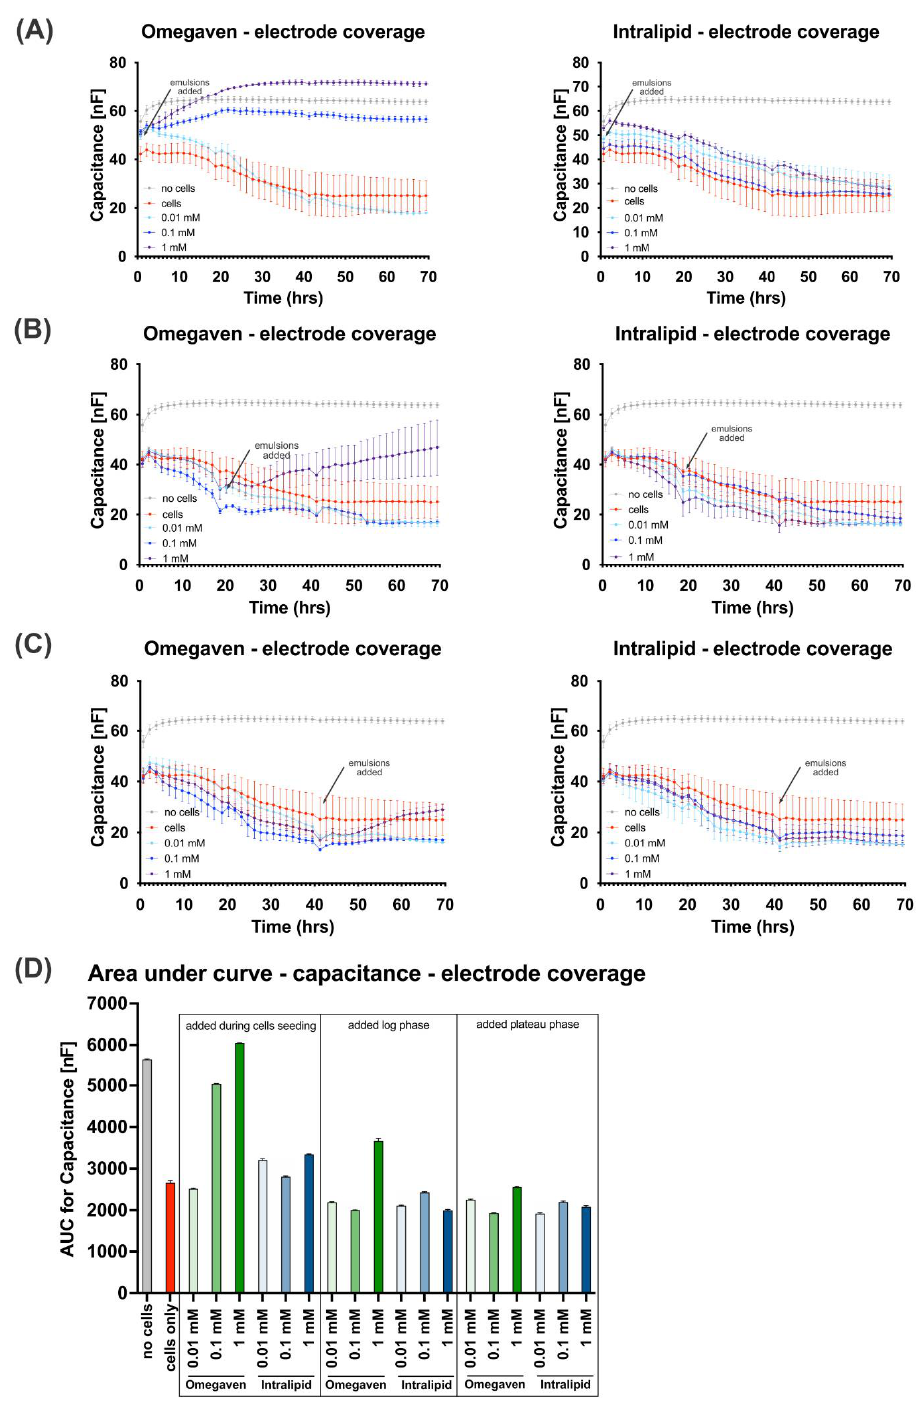
Figure 3. Omegaven ® increases the capacitance indicating reduced electrode coverage. Omegaven ® and Intralipid ® lipid emulsions at 0.01, 0.1 and 1 mM concentrations were added to endothelial cells during cell seeding on the ECIS electrode ( A ), in the cells logarithmic growth phase ( B ), and in cells plateau growth phase ( C ). The electrode coverage was monitored by an ECIS ® Z θ (Z Theta) device, and 60 measurements of capacitance (nF) in 70 h were recorded for cells grown in triplicates. The decrease in capacitance of cells grown on the electrode is directly proportional to the electrode coverage. Therefore, the higher values indicate the lower electrode coverage by cells. For the graph presented in ( A – C ), areas under the curve ( D ) were analyzed using (GraphPad, San Diego, CA, USA), X.Y. analysis/Area under curve